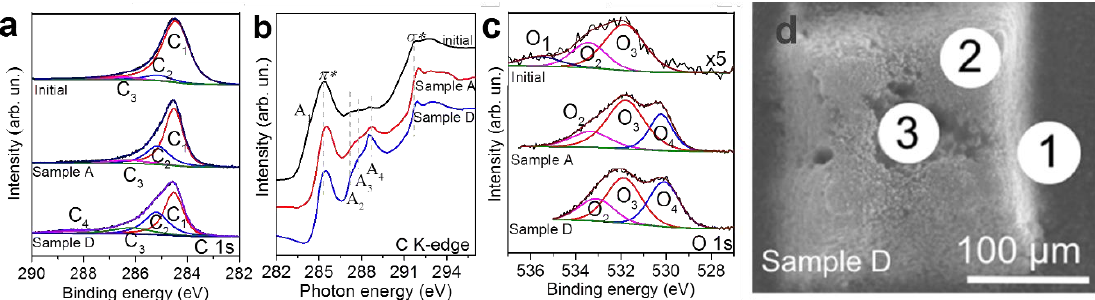
Figure 2. XPS C 1s ( a ), NEXAFS C K-edge ( b ), and XPS O 1s ( c ) spectra of initial and engraved MWCNT arrays. SEM image of a column of Sample D ( d ). Circles indicate regions used for EDX analysis.